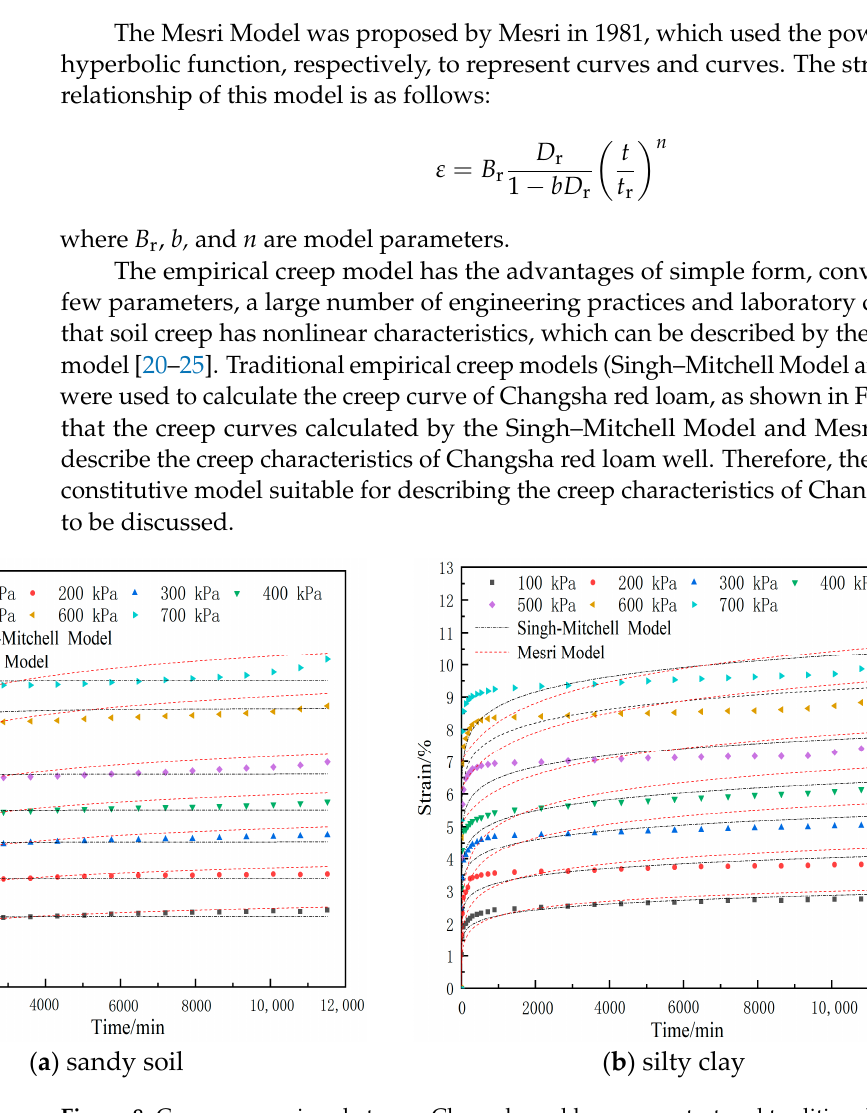
Figure 8. Curve comparison between Changsha red loam creep test and traditional empirical